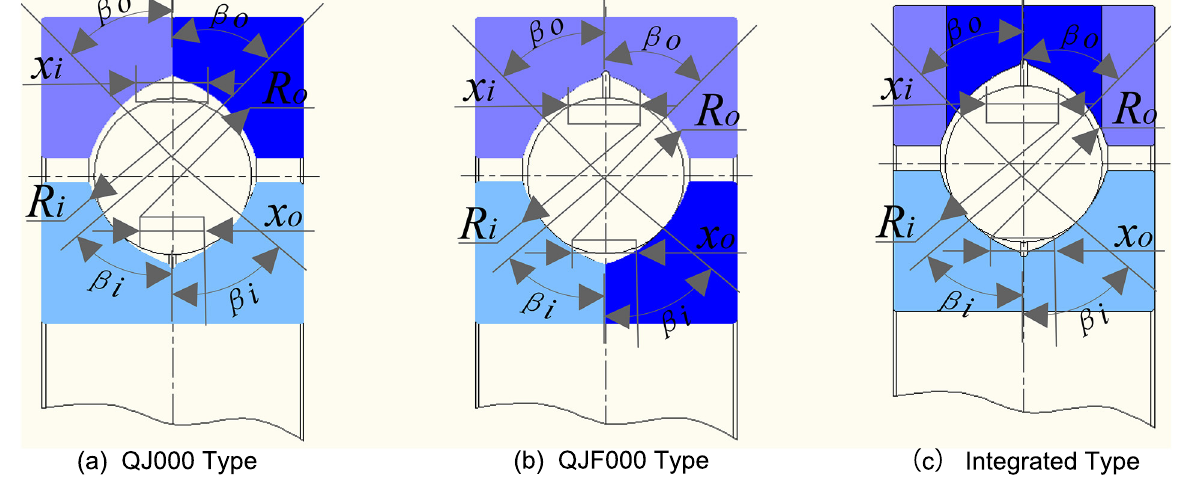
Fig. 1 Structures of four-point-contact ball